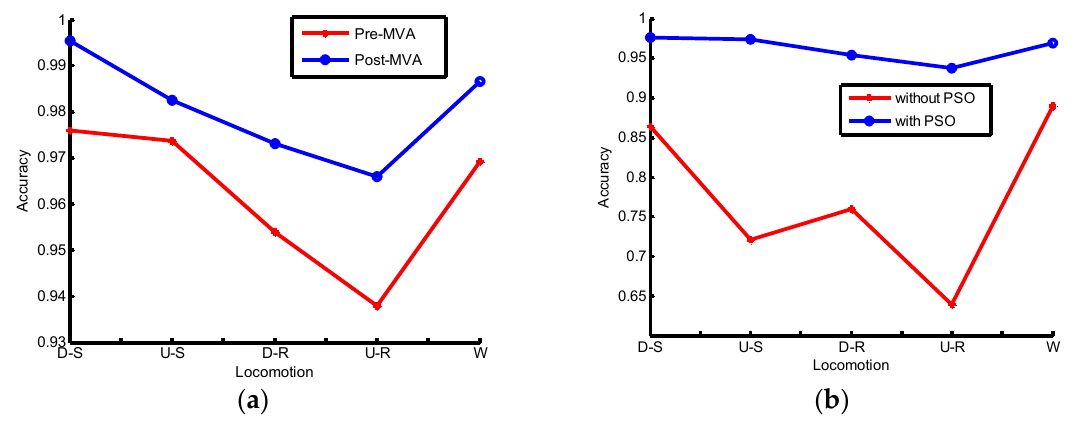
Figure 14. The online identification accuracy comparisons for several locomotion modes: